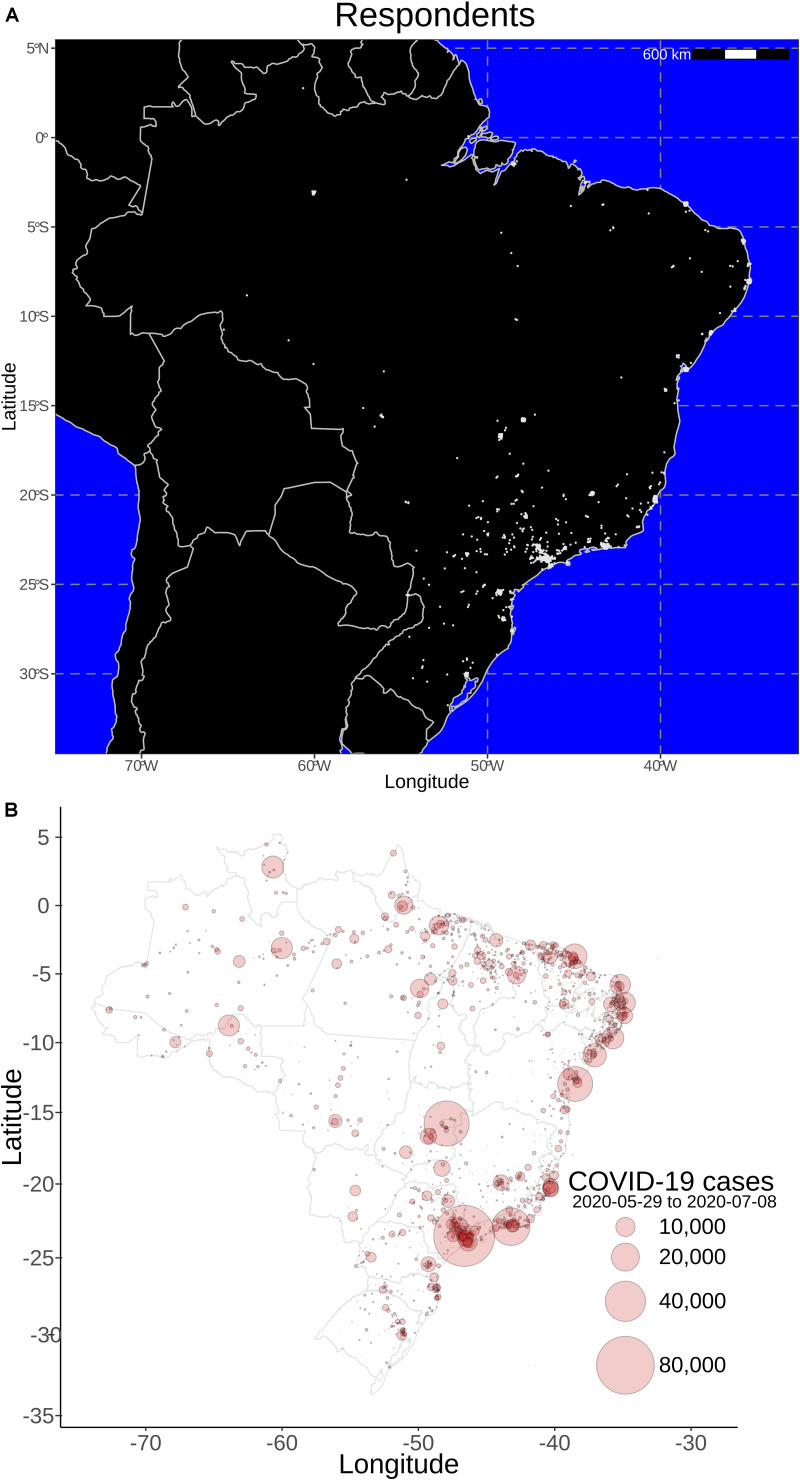
Geo-localization of online survey participants and epidemiological data. Approximate location of respondents who enrolled in the online survey (A), indicating that the major coronavirus disease 2019 (COVID-19) hot spots in Brazil (B) are represented in the collected data (May 29, 2020 to July 8, 2020). Most of participants were from São Paulo, which has been the Brazilian epicenter.